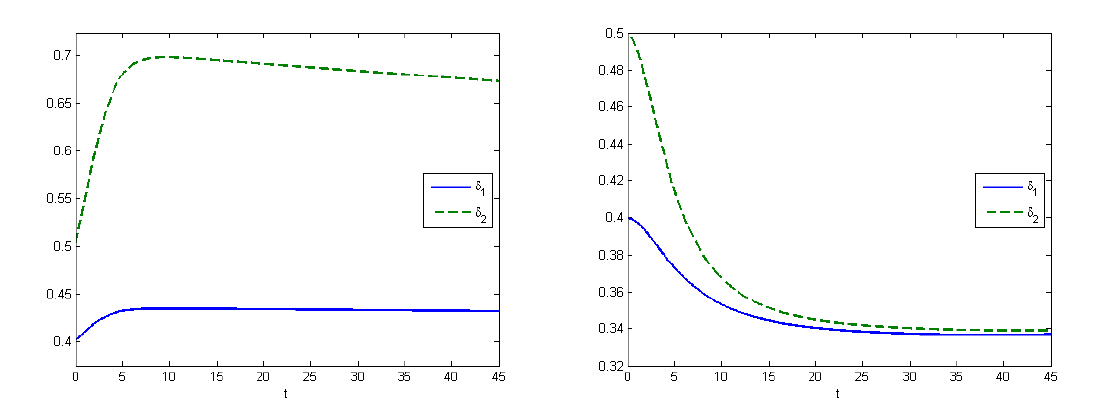
Figure 6. Experiment 3. Left : SIR model with virus mutation and application of control. Functions h i ( u i ) are convex. Vertical axis shows the fractions of the subpopulations. Right : Optimal control in SIR model with virus mutation and convex-cost functions h i ( u i ) . Vertical axis shows the amount of applied control at time moment t .